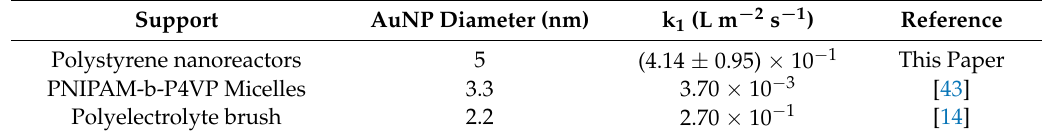
Table 2. Rate constants for various metal/polymer nanocomposite